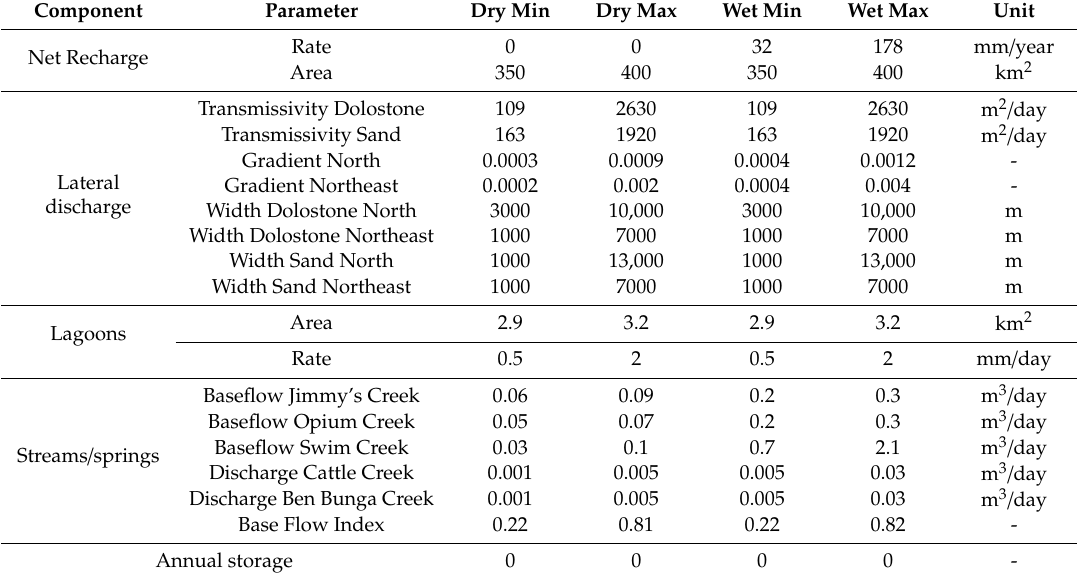
averages over the whole area. Table 2. Parameter values describing the water balance components in the Wildman River area. The parameters are described with a uniform distribution between the minimum and the maximum value in the dry and wet season. Parameters that describe areas, width and transmissivities are constant over the year, and therefore only described by one set of a minimum and a maximum value. The term sand refers to Mesozoic–Cenozoic (Mz / Cz) sand, while the term Dolostone refer to the Koolpinyah